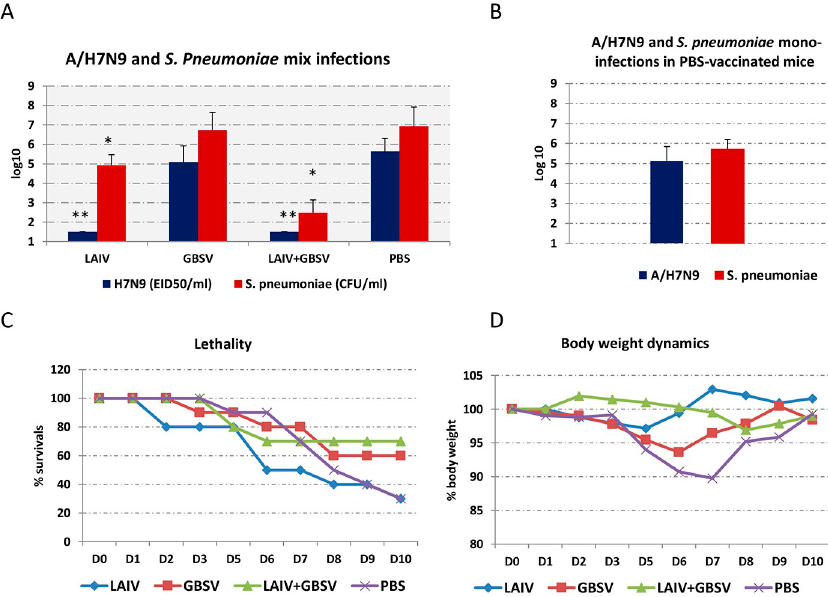
Fig 3. The A/Shanghai/2/2013(H7N9) CDC-RG influenza virus and S . pneumoniae serotype 3 isolation from the lungs. (A) Influenza virus and S . pneumoniae titers in the lungs with mixed virus-bacterial infection at 72 hours after primary viral infection (n = 6–8); � —P < 0.01, �� —P < 0.001 compared to mock-vaccinated animals. (B) Influenza virus and S . pneumoniae titers in the lungs of mock-vaccinated animals at 72 hours after A/H7N9 mono-infection or after 48 hours after S . pneumoniae serotype 3 mono-infection (n = 6). () lethality after mixed influenza and pneumococcal infections (n = 10)/ (D)–body weight dynamics after mixed influenza and pneumococcal infections (n =